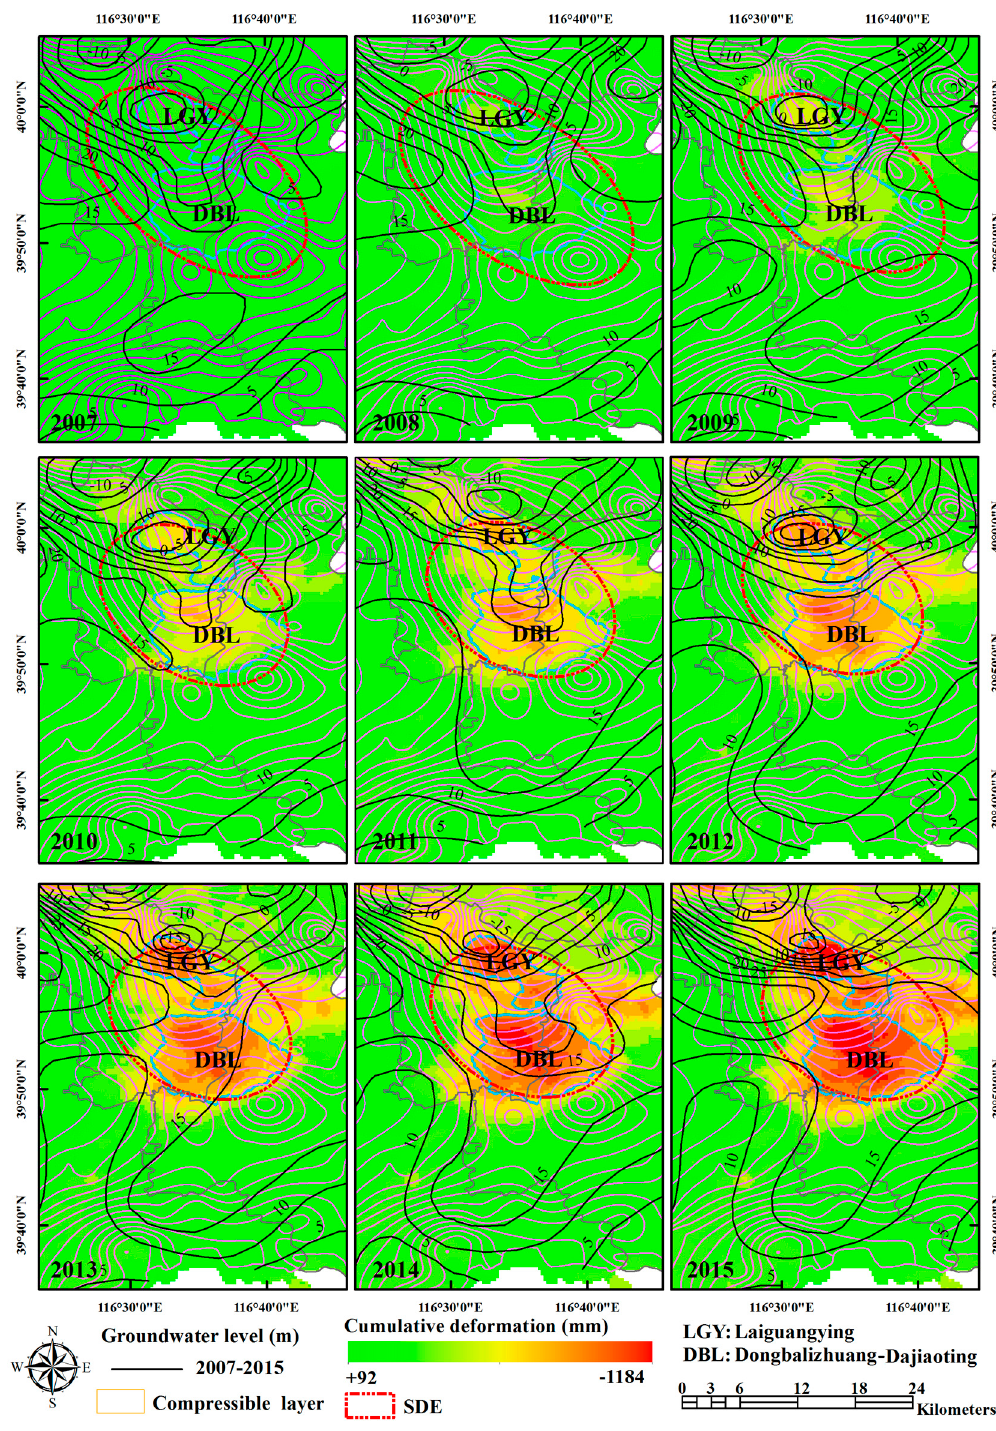
Figure 9. The spatial evolution patterns of land subsidence obtained by the SDE method. The black countours indicate the changing groundwater level data from 2007 to 2015. The heliotrope lines represent the compressible sediment layer data. The red ellipses indicate the SDEs for every year. In addition, the groundwater level is referenced to sea level.